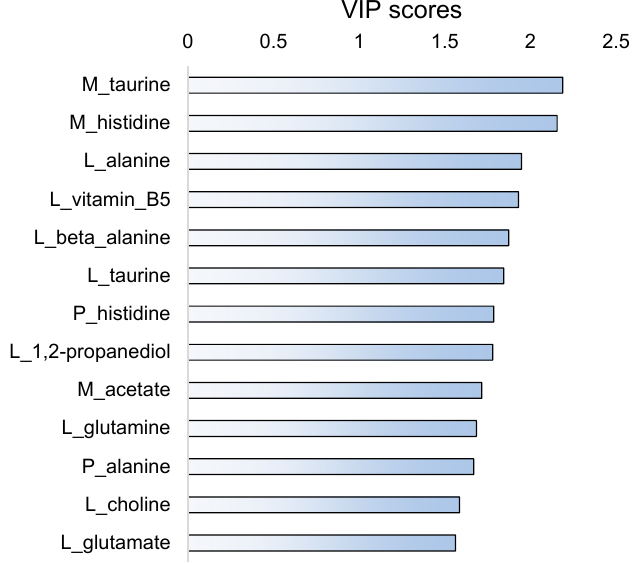
Figure 3. Variable importance in the projection (VIP) scores from the OSC-PLS-DA of 84 metabolites measured in fish plasma (P_), liver (L_) or muscle (M_), for fish fed PB, INS05, INS10 or INS15 diet for 84 days presented Figure 2. The scores values of the 13 variables with a score higher than 1.5 are presented.